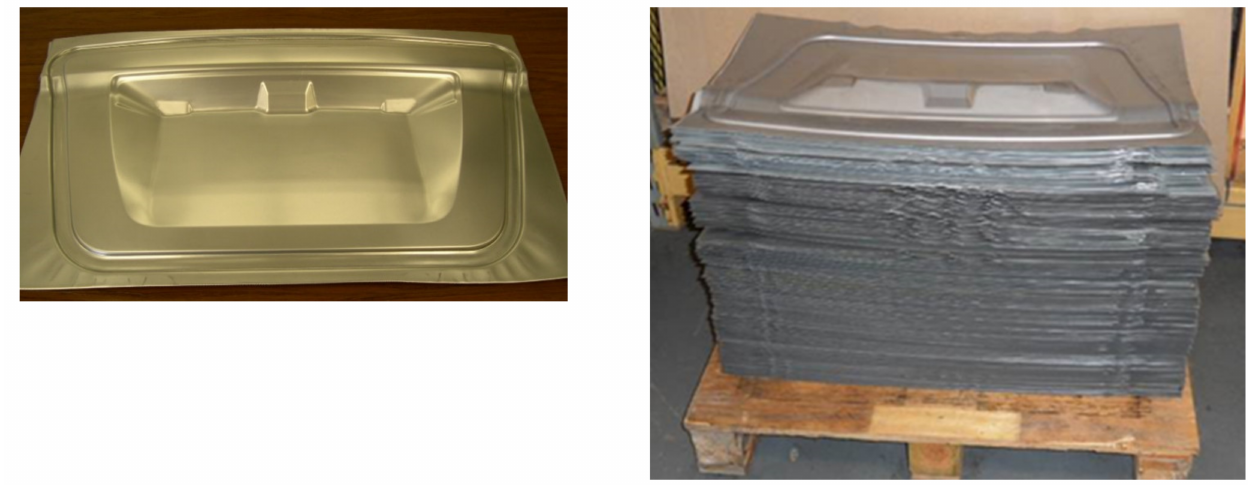
Figure 7. EHF formed prototype part from Aluminum Alloy